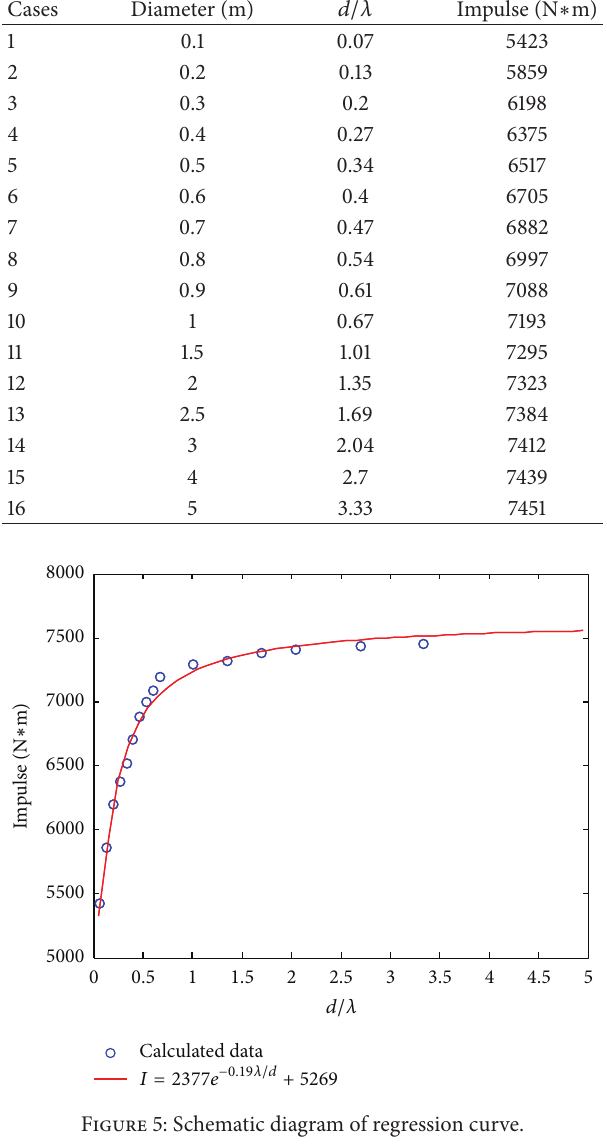
Table 2: Calculated impulses of cylindrical shells with different diameters.